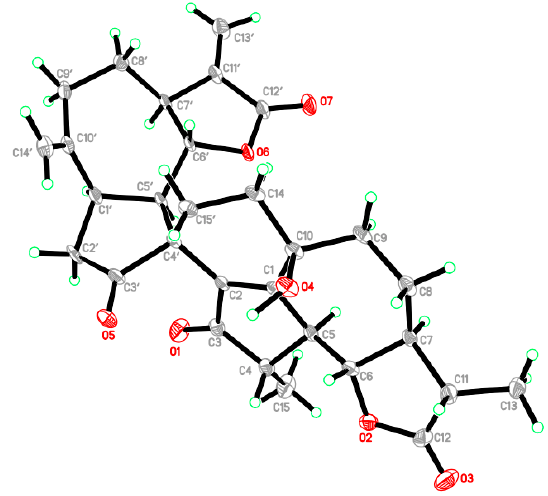
Figure 2. Single-crystal X-ray structure of Compound 1 .